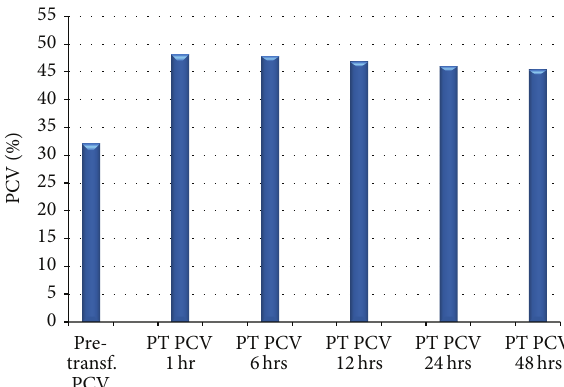
Figure 1: Mean PCV values before and after packed cell blood